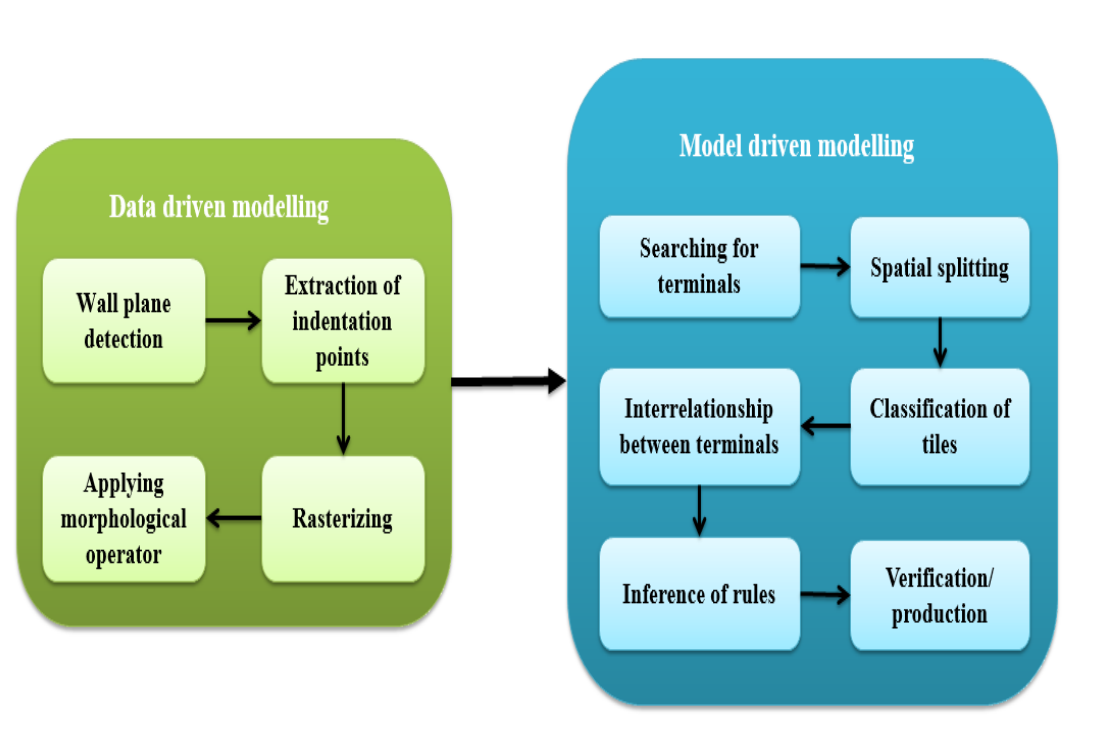
Figure 1. Processing flowchart of the grammar based façade